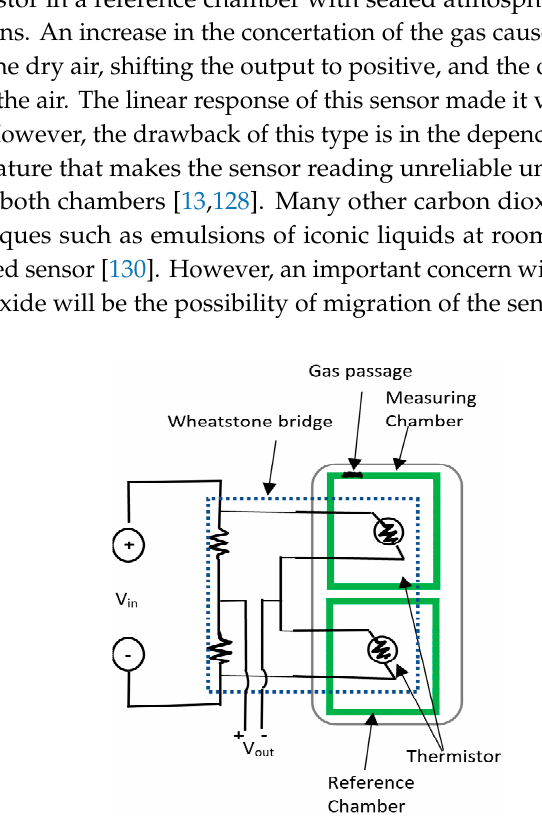
Table 3. Photophysical properties of commonly used oxygen dyes in oxygen sensing.